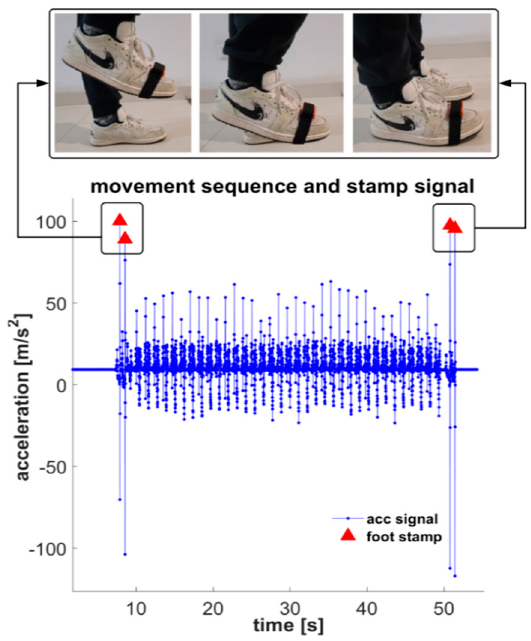
Figure 2. The acceleration magnitude of stomps is distinctly larger than the that of walking.